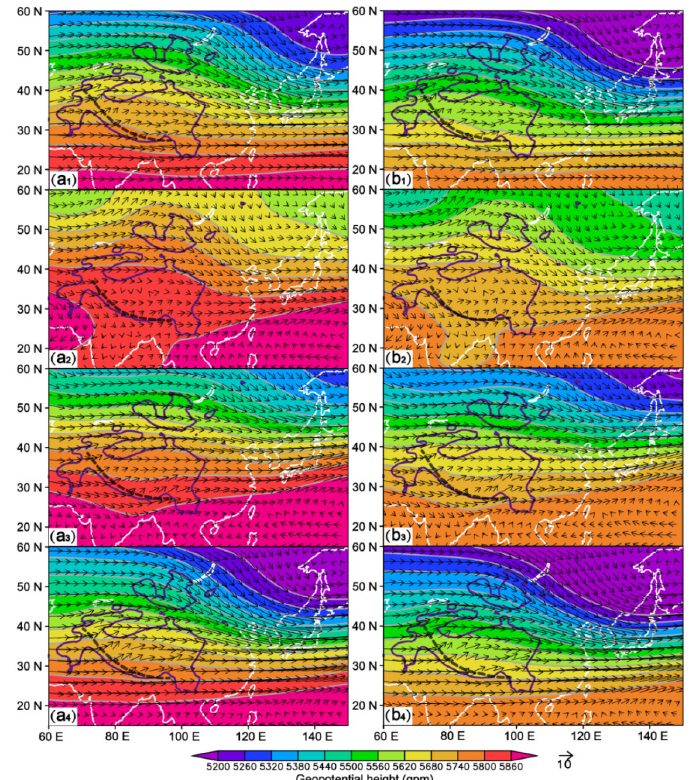
Figure 7. ECMWF-predicted ( a 1 – a 4 ) and reanalyzed ( b 1 – b 4 ) 500 hPa geopotential heights (shaded; units: gpm) and wind vectors (units: m · s − 1 ) of March ( a 1 , b 1 ), June ( a 2 , b 2 ), October ( a 3 , b 3 ), and December ( a 4 , b 4 ) averaged over the three years (2016–2018). The Qinghai-Tibet Plateau and the Mongolian Plateau are purple-shaded. Black-dashed lines stand for wind